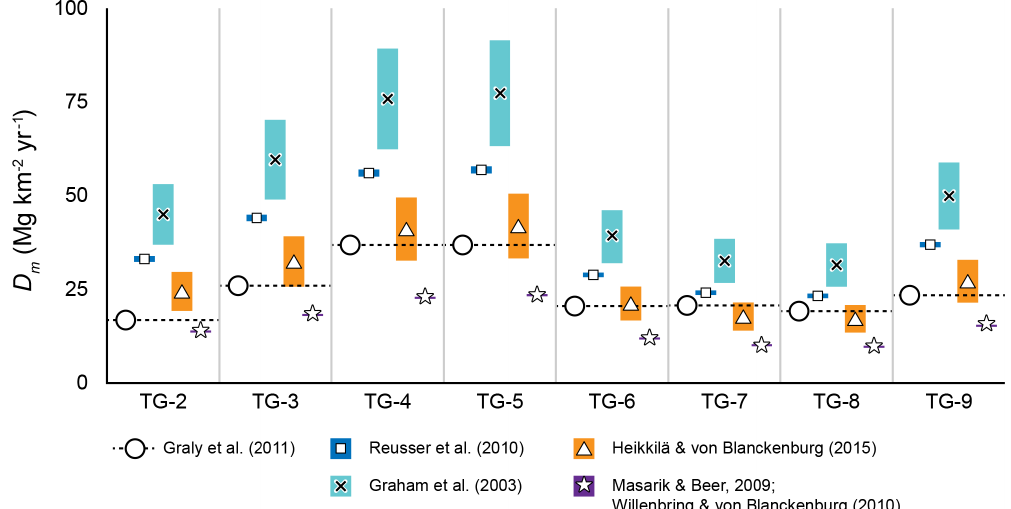
Figure 11. Comparison of denudation rates, D m , using the von Blanckenburg et al. (2012) method; a bedrock beryllium concen- tration, 9 Be parent , value of 4.1ppm (Beus, 1962), measured values from stream sand (Table 3); and meteoric 10 Be delivery rates, 10 Be F 6 atoms cm − 2 yr − 1 to 1.72 × 10 6 atoms cm − 2 yr − 1 (Reusser et al., 2010; blue, square), 1.9 × 10 6 atoms cm − 2 yr − 1 to met , of 1.68 × 10 2.7 × 10 6 atoms cm − 2 yr − 1 (Graham et al., 2003; turquoise, black X), 1.0 × 10 6 atoms cm − 2 yr − 1 to 1.5 × 10 6 atoms cm − 2 yr − 1 (Heikkilä and von Blanckenburg, 2015; orange, triangle), ∼ 7 × 10 5 atoms cm − 2 yr − 1 (Masarik and Beer, 2009; Willenbring and von Blanckenburg, 2010; purple, star), and 8.5 × 10 5 atoms cm − 2 yr − 1 to 1.5 × 10 6 atoms cm − 2 yr − 1 (Graly et al., 2011; white circle with dashed black